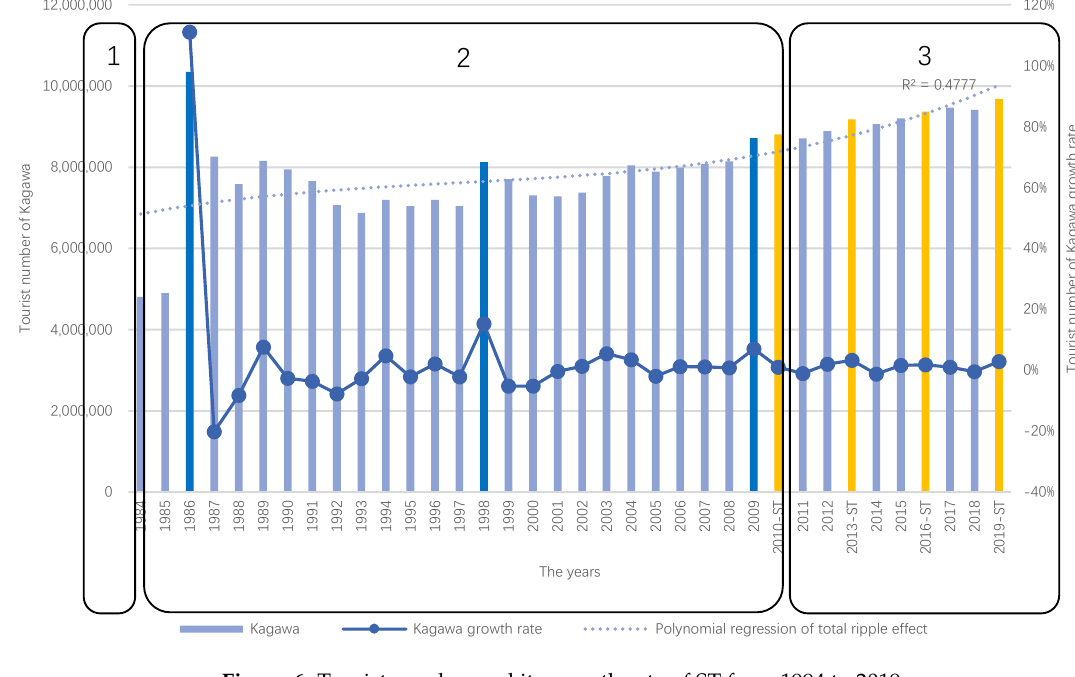
10 of 18 Figure 5. The economic ripple effect of ST in Kagawa. Note: The ripple effect (based on related cal- culation table in Kagawa) is often used colloquially to mean a multiplier in macroeconomics. Figure 6 shows the changes in the number of tourists and the growth rate in Kagawa.